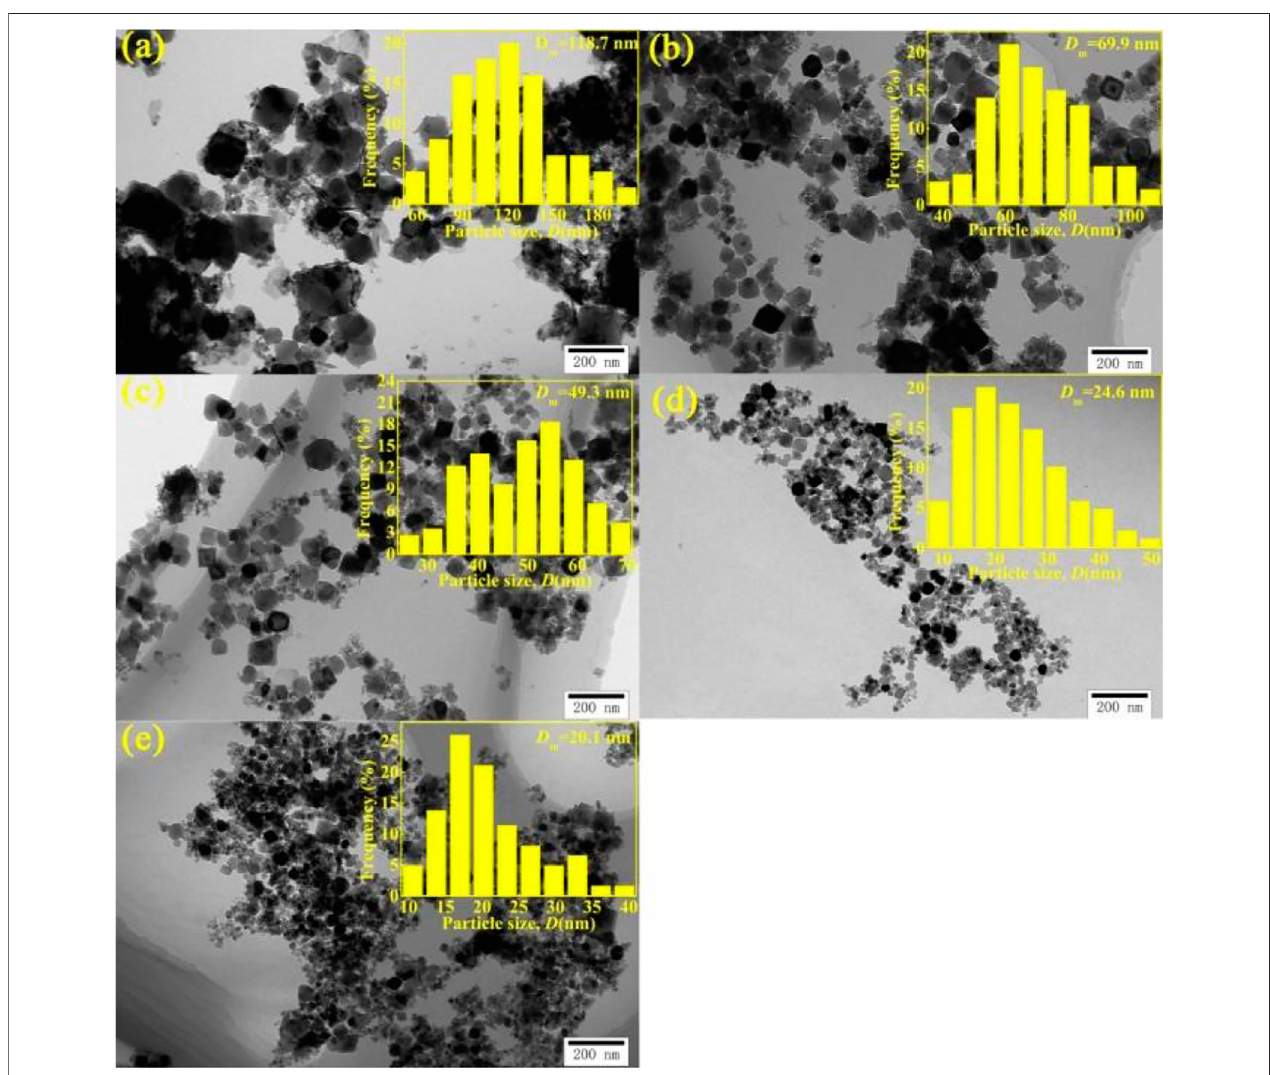
FIGURE3| TEMimagesandsizedistributionsofFe 3 O 4 nanoparticlespreparedatdifferenttemperatures: (A) 18 ° C(RT), (B) 35 ° C, (C) 45 ° C, (D) 60 ° C,and (E) 80 ° C, and the insets represent of particle sizes.